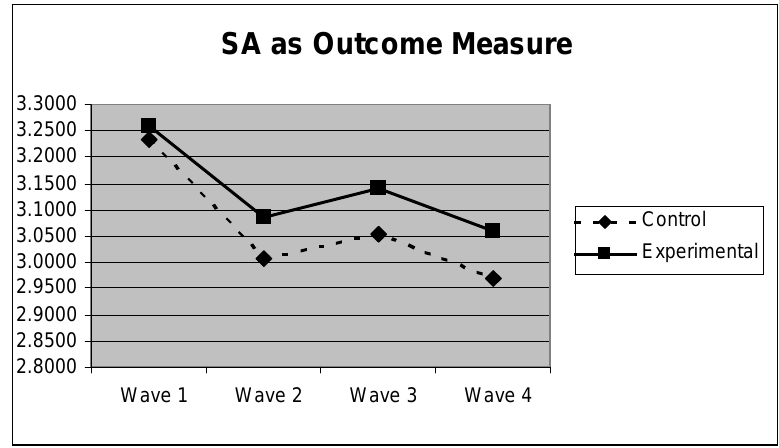
FIGURE 4. Growth trajectories in the experimental participants participating in the Tier 1 Program and control participants using SA as an outcome